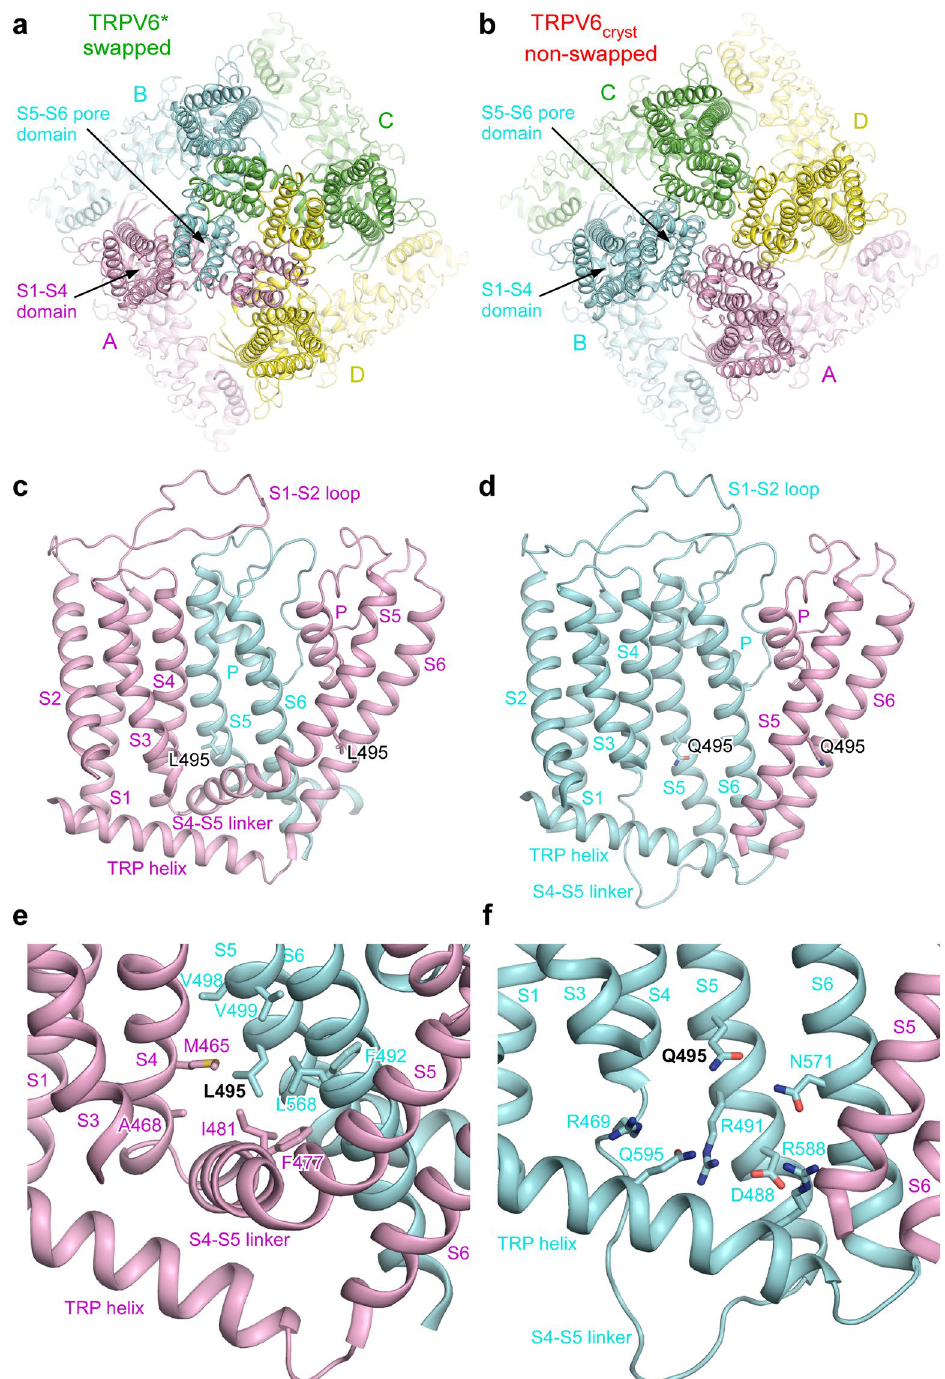
Figure 3. Non-swapped domain arrangement as a result of single residue substitution. ( a - b ), Extracellular views of TRPV6 * ( a ) and TRPV6 cryst ( b ) with four subunits (A–D) each shown in different color. Note, the peripheral S1–S4 domains are adjacent to the S5–S6 pore domains of the same subunit in TRPV6 cryst , while the adjacent domains are from neighboring subunits in TRPV6 * . ( c , d) Side views of one S1–S4 domain and two S5–S6 pore domains illustrating S4–S5 and S6-TRP helix connectivity unique to swapped ( c ) and non-swapped ( d ) architectures. ( e , f) Close-up views of the regions surrounding L495 in TRPV6 * ( e ) and Q495 in TRPV6 cryst ( f